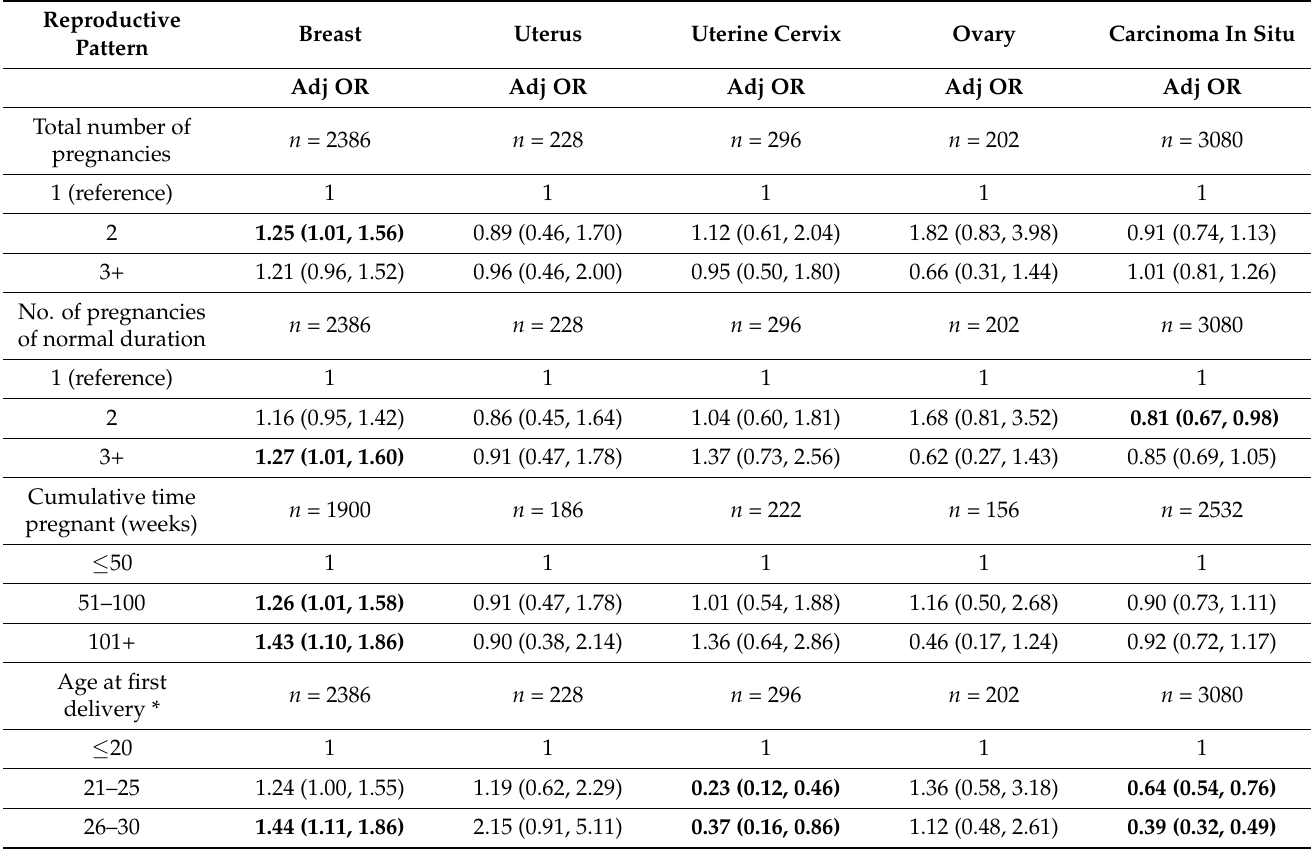
Table 3. Subgroup analyses by cancer site (breast/gynaecological cancers): reproductive variables by case-control status.